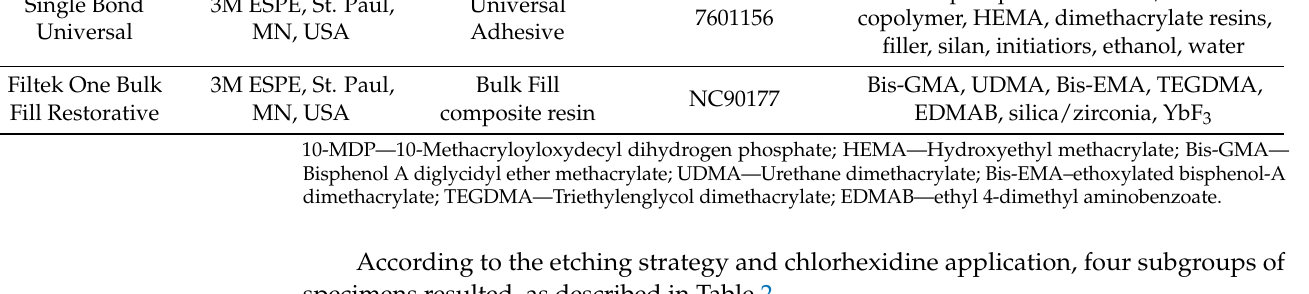
Table 1. Composition of the materials.